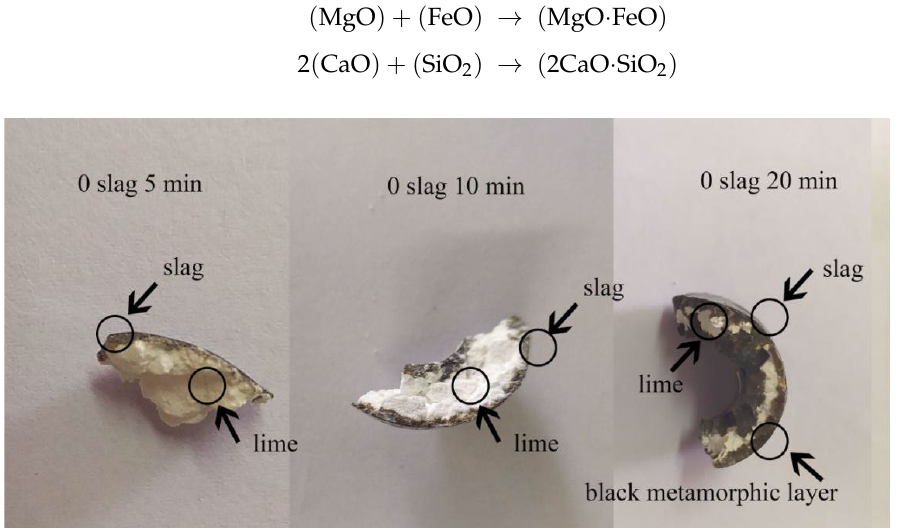
Figure 9. Dissolution process of lime in Sample 0 slag.